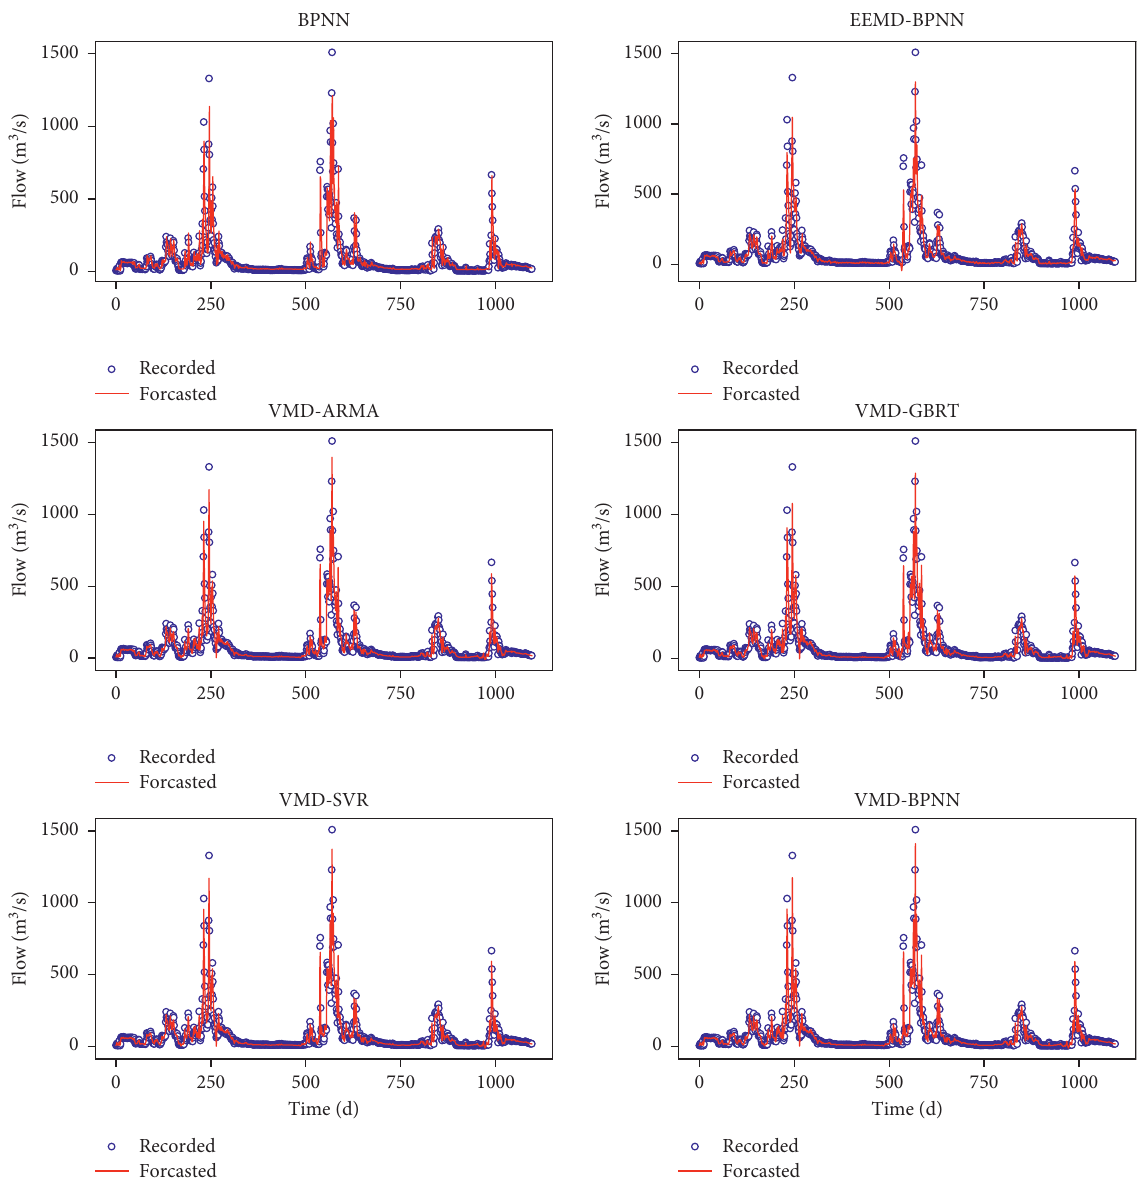
Figure 7: Comparison of the records and predicted streamflow results of the BPNN, EEMD-BPNN, VMD-ARMA, VMD-GBRT, VMD- SVR, and VMD-BPNN models during the testing phase (01/01/2012–31/12/2014) at the Weijiabao